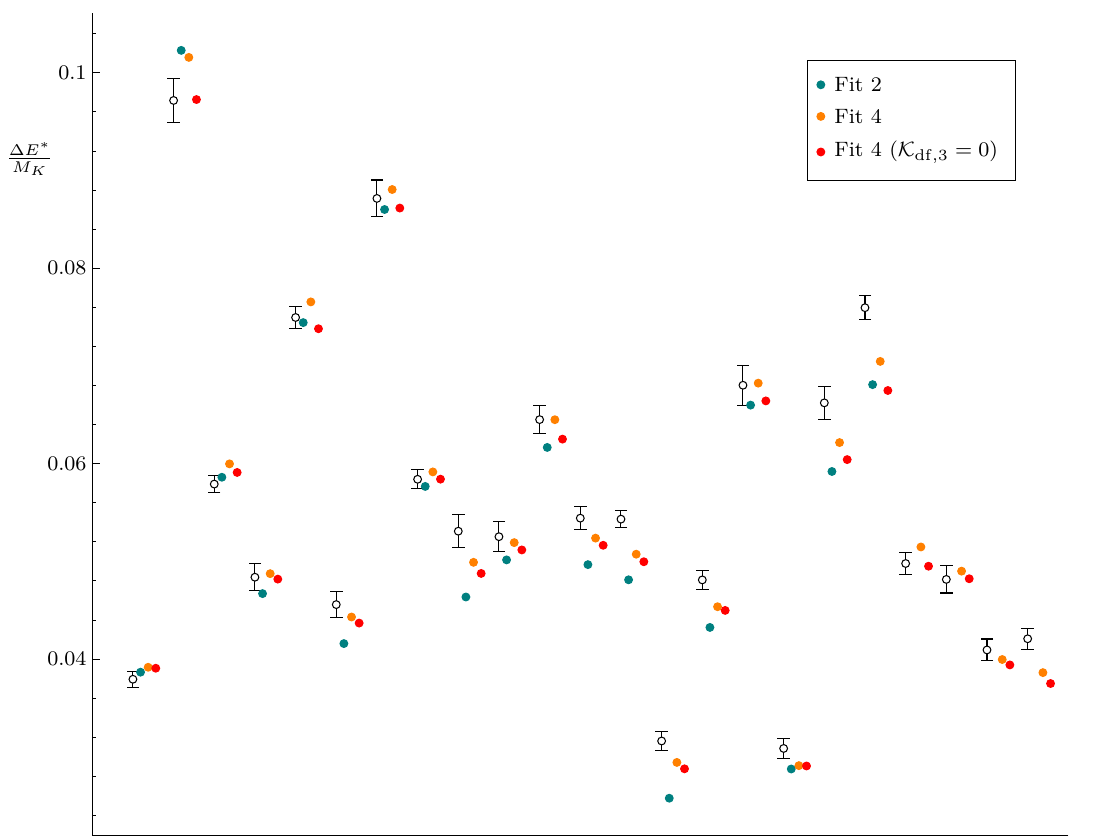
Figure 4. Shifts from the noninteracting levels for three-kaon states included in our fits on the N200 ensemble. Each energy is labeled at the bottom by the irrep, total momentum-squared, and the energy level (with 0 indicating the lowest level in the channel, etc.). For each level, the shifts determined from the lattice simulation are given by the open circles with error bars, followed to the right by the predictions of fit 2 (teal), fit 4 (orange), and fit 4 with K df , 3 = 0 (red), respectively. The predictions for fit 2 are absent for the four nontrivial irreps on the right, as these levels were not included in this fit. See text for further